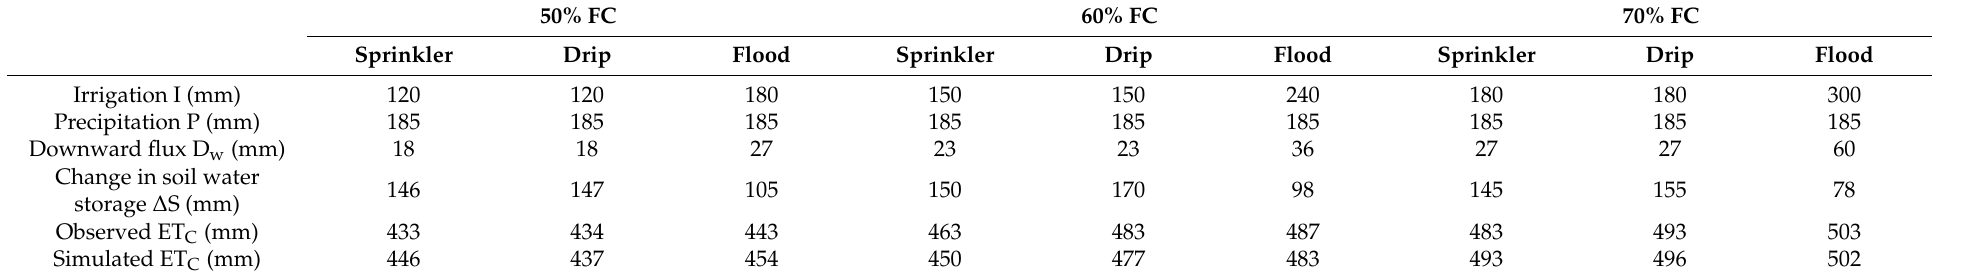
Table 7. Soil water balance in the top one-meter soil profile during the 2016–2017 growing season.